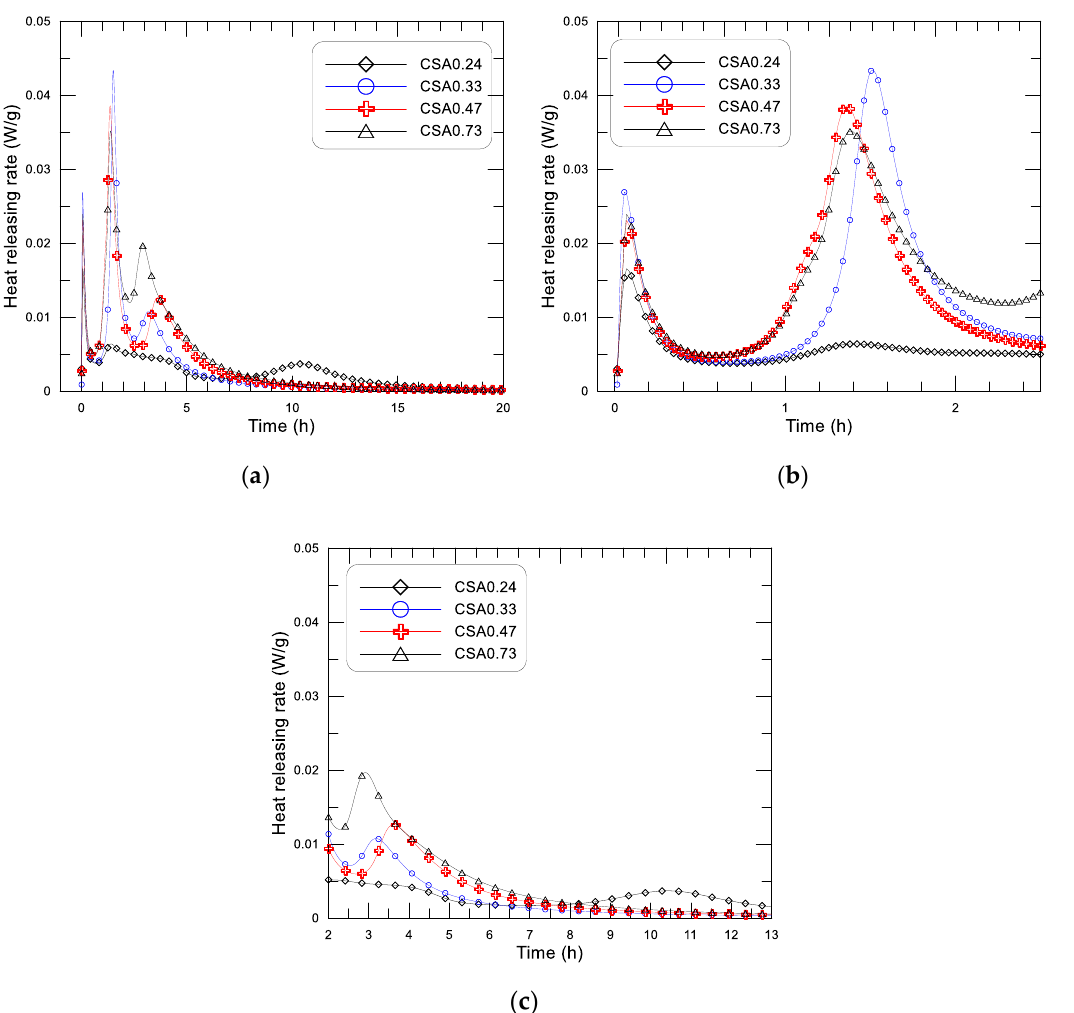
Figure 9. Heat-releasing rate of the CSA paste with different w/c: ( a ) results of 20 h, ( b ) results of the initial 2.5 h, ( c ) results of 2–13 h.